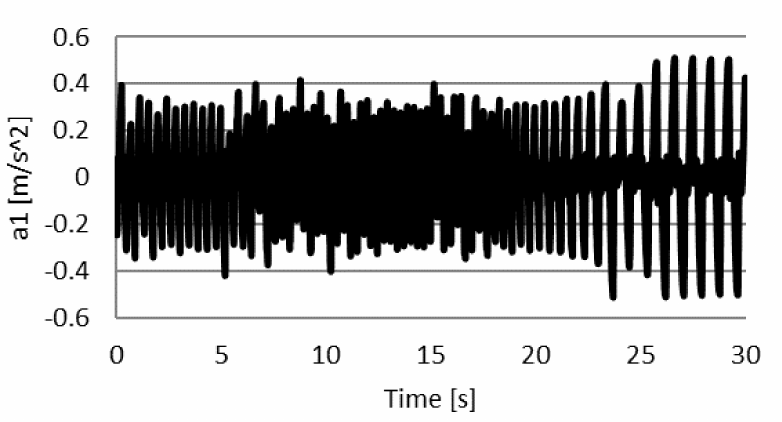
Figure 16. The change in vertical acceleration over the front axle with control by criterial function K ( 1 )